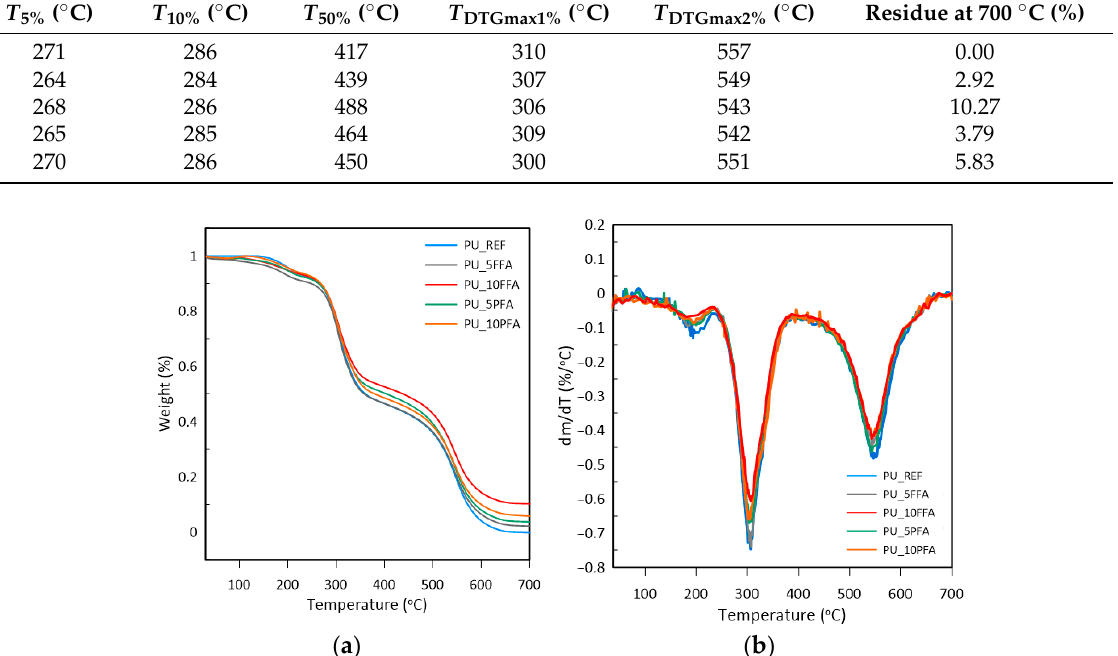
Figure 7. ( a )Thermogravimetry curves; ( b ) Derivative thermogravimetry curves of RPUFs. Figure 7. ( a ) Thermogravimetry curves; ( b ) Derivative thermogravimetry curves of